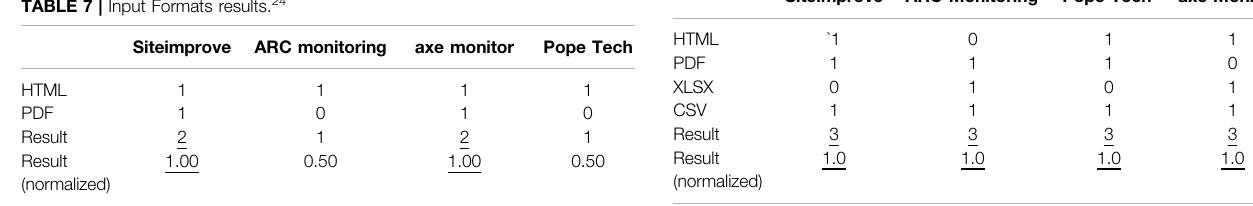
TABLE 7 | Input Formats results. 24